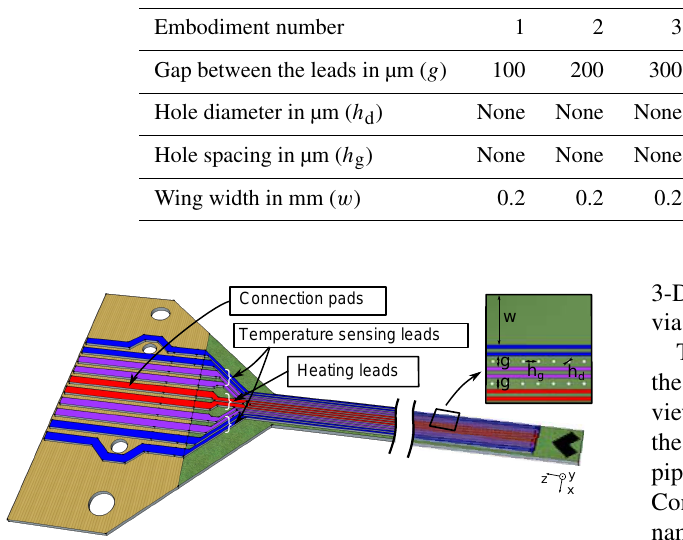
Figure 2. Schematic of the calorimetric transducer layout: the length of the meander is 50mm and the overall thickness is about 140µm (100µm substrate and 40µm solder resist). Copper layers 5µm thick are embedded in the solder resist. The heating leads are red, the sensing ones are blue and purple, the solder resist is green and the substrate is yellow. At the left of the transducer are connec- tion pads for soldering or a plug. Also, a detail of the transducer part gives an overview of the varied parameters: g is the gap between the leads, h d is the hole diameter, h g is the hole spacing, and w is the wing